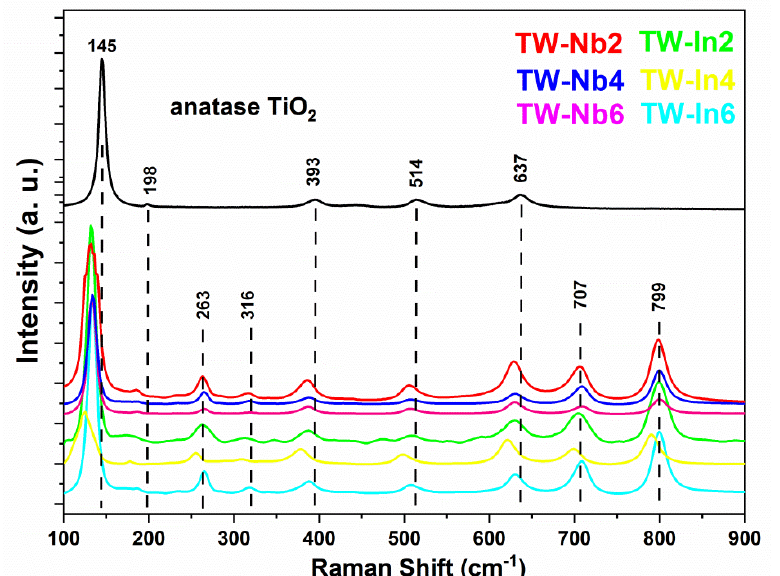
Figure 5. Raman spectra of the TW − Nb and TW − In MMO nanocomposites and pristine anatase 𝑇𝑖𝑂 (cid:2870) nanoparticles.